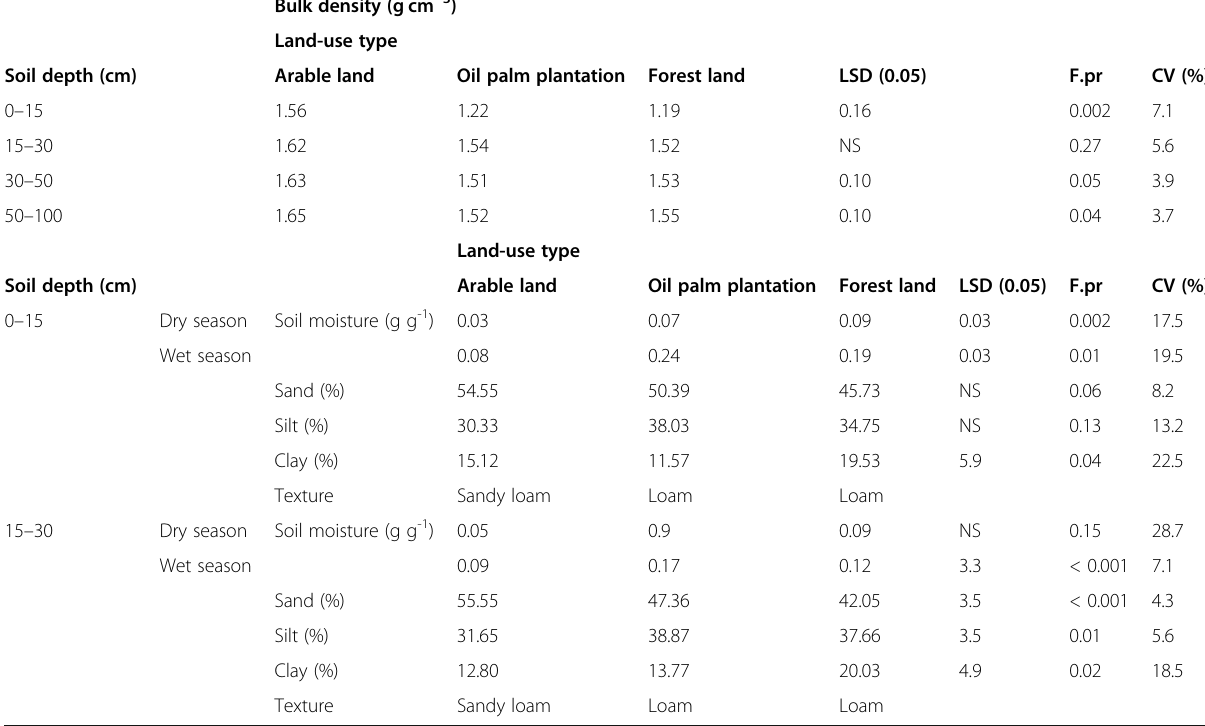
Table 1 Soil physical characteristics in the land-use